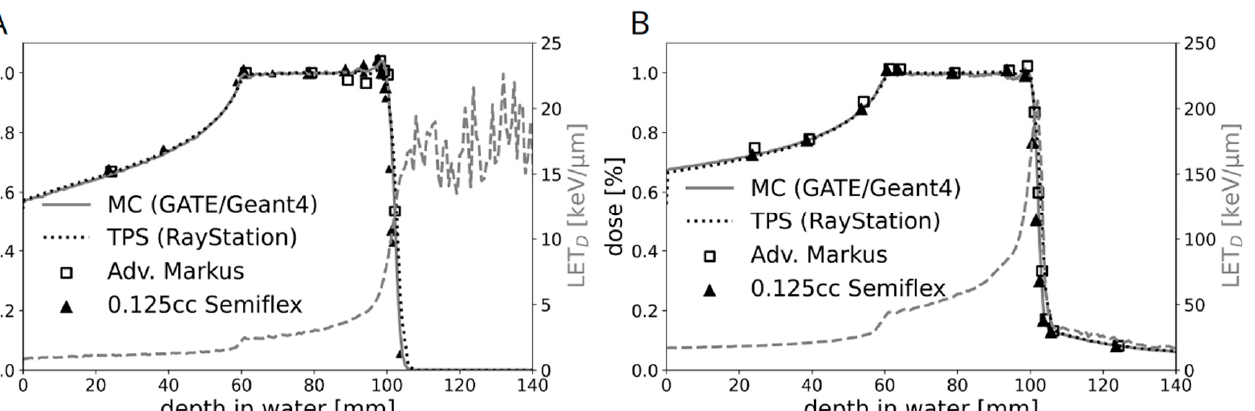
Figure 1. Illustration of the different treatment techniques, shown on a representative booster plan for the gross tumor volume (red) in the paranasal sinus region. The conventional treatment method (( A ) volumetric modulated arc therapy) shows a higher dose delivered to organs at risk, e.g., the chiasm (purple), both optic nerves (yellow and blue), and the brainstem (green). The dose distribu- tion of the pencil beam scanning technique with ( B ) protons and ( C ) C-ions show better sparing of the organs at risk, especially visible in the right optical nerve and brainstem, while achieving a com- parable tumor coverage.